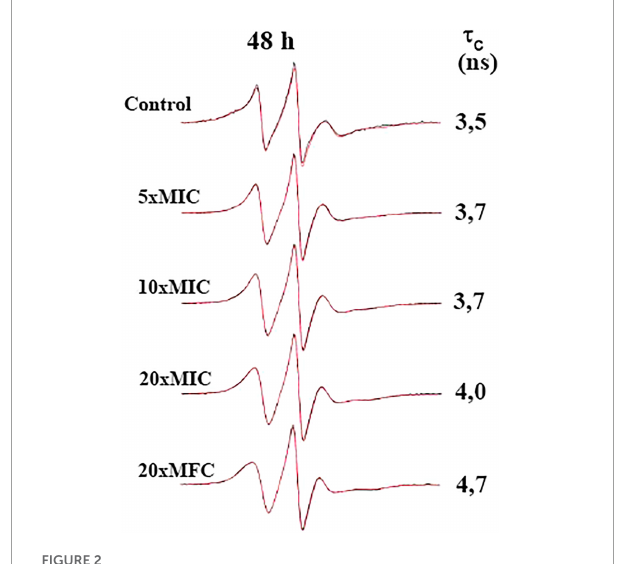
FIGURE2 Effect of N -(butylcarbamothioyl) benzamide (BTU-01) on Cryptococcus neoformans plasma membrane fluidity. EPR experimental spectra (black) and best-fit (red) of 5-DSA spin label incorporated into plasma membrane of C. neoformans ATCC 34872 treated with different concentrations of BTU-01 (5xMIC; 10xMIC; 20xMIC; and 20xMFC) for 48 h. The simulated spectra (red) were provided by the NLLS program using a two-component spectral model. The rotational correlation time ( f c) values provided by the simulation program were indicated. In all EPR spectra the total scan range of the magnetic field 100 G ( X -axis) and the intensity ( Y -axis) is in arbitrary